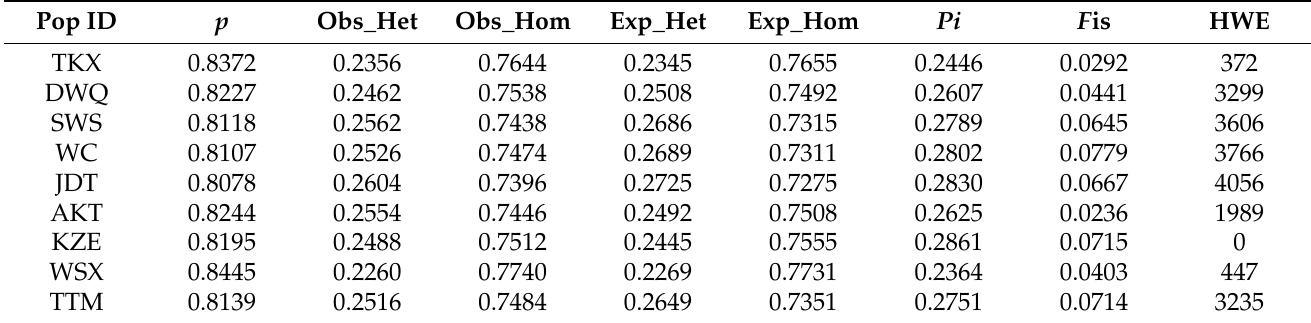
Table 2. The genetic diversity and allele polymorphism of nine